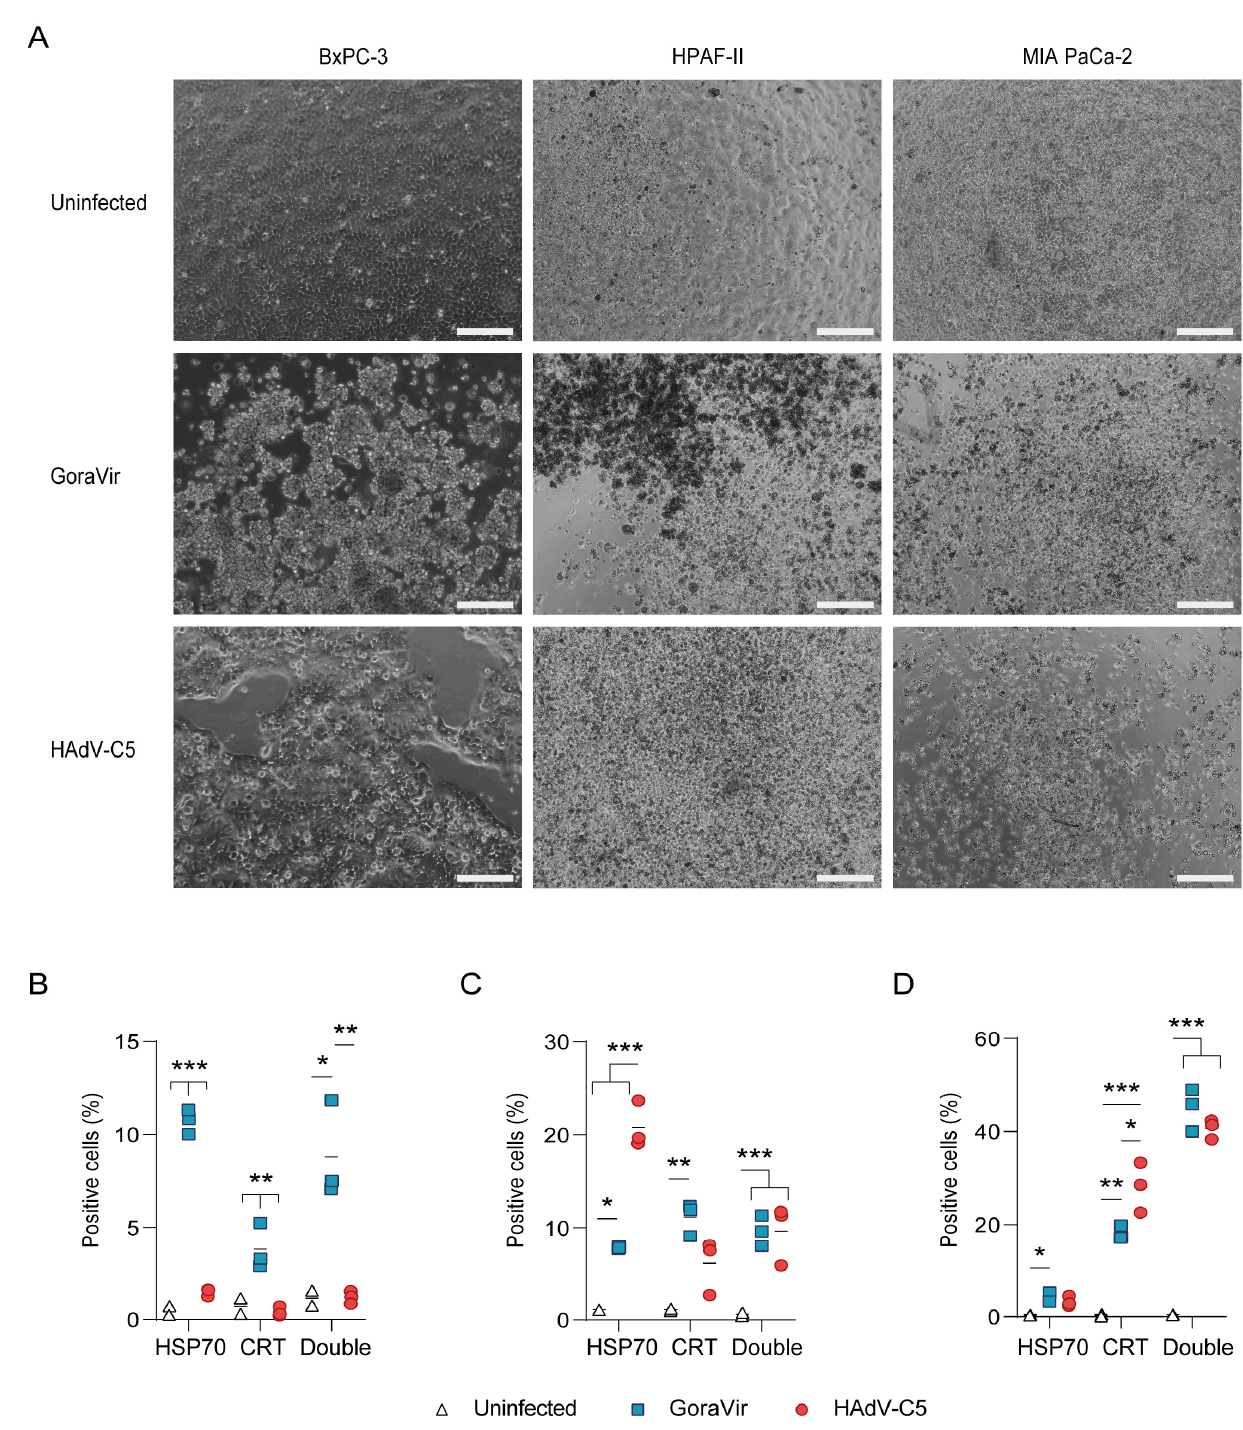
Figure 2. Protein expression of immunogenic cell death (ICD) markers in pancreatic cancer cell lines upon infection with GoraVir and HAdV-C5. ( A ) Light microscopy images of pancreatic cancer cells infected with GoraVir or HAdV-C5 at 72 hpi. Scale bar represents 500 µ m; ( B ) BxPC-3, ( C ) HPAF-II, and ( D ) MIA PaCa-2 cells were infected with GoraVir or HAdV-C5 at MOI 10 and 72 hpi. The percentage of calreticulin (CTR)-positive, HSP70-positive, or double-positive cells was determined by flow cytometry. Means are depicted of n = 3 biologically independent replicates. Means were compared using one-way ANOVA with Tukey correction for multiple testing. Significant differences are indicated by asterisks, with p values < 0.05 shown as *, <0.01 shown as **, and <0.001 shown as